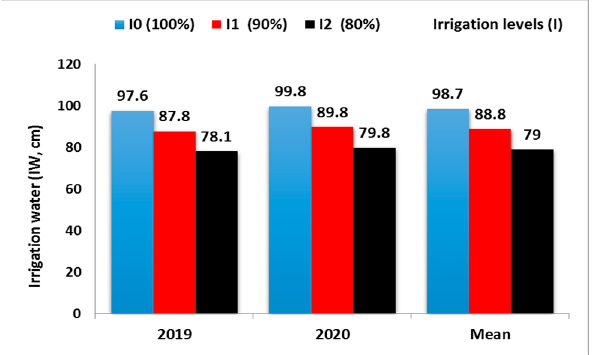
Figure 1. Amount of irrigation water (IW, cm) for soybean crop during the two growing